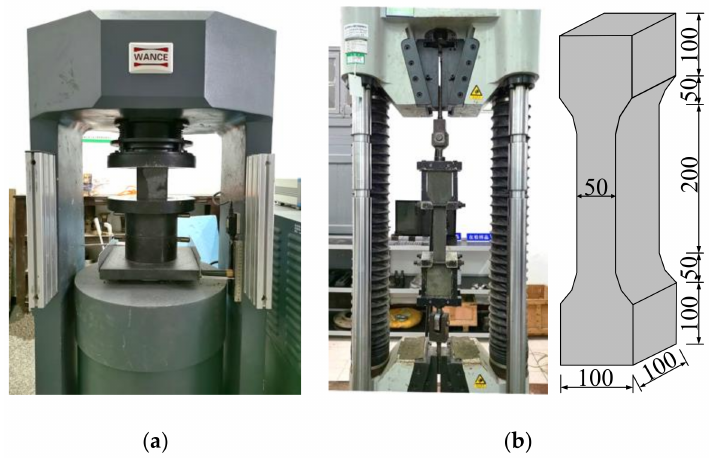
Figure 2. Test setup for UHPC mechanical properties: ( a ) compressive test; ( b ) direct tension test.